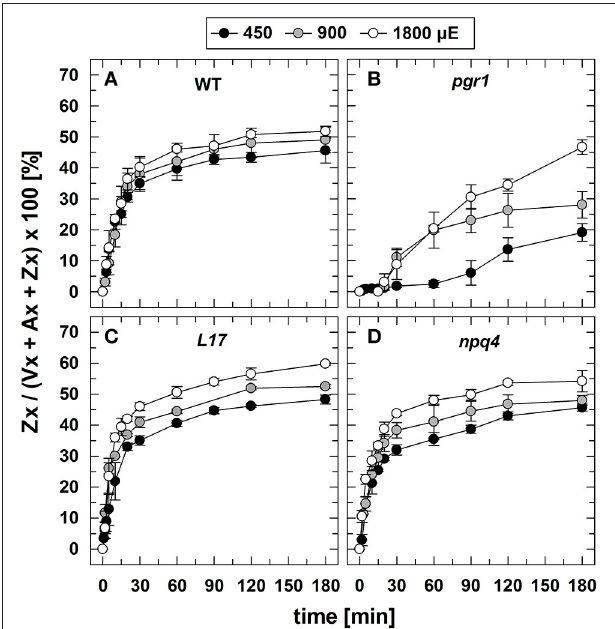
FIGURE 3 | Zx synthesis. The synthesis of Zx during 180min of illumination at three different actinic light intensities (450, 900, and 1,800 µ E of white light) is shown for (A) WT, (B) pgr1 , (C) L17 , (D) npq4 plants. Detached leaves were placed on water in temperature-controlled cuvette (20 ◦ C). At indicated time, leaves were rapidly frozen in liquid N 2 and the pigment composition was determined by HPLC analyses. The Zx content in % of the total VAZ-pool size ( = sum of Vx, Ax and Zx) is shown. Data represent mean values ± SE of 3–4 independent